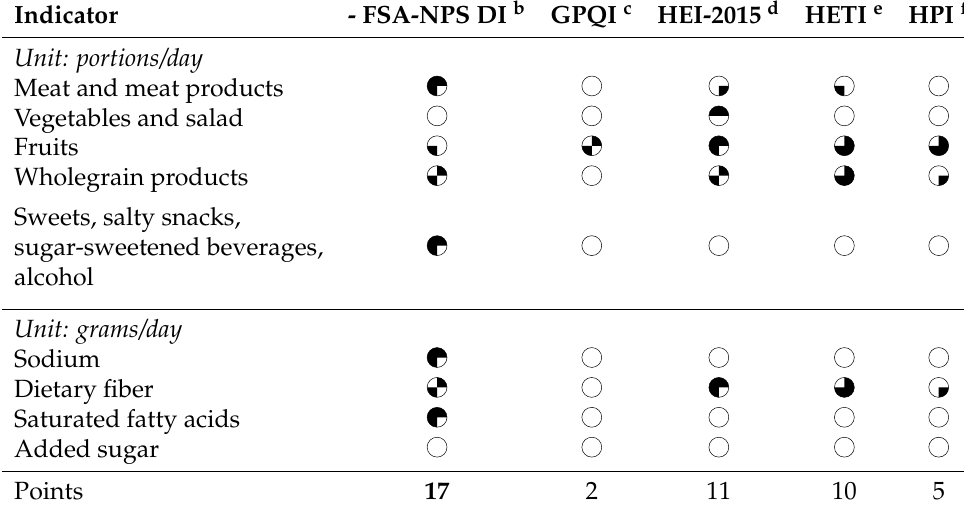
Table 6. Discrimination potential of relevant food shopping quality indicators to differentiate health- relevant individual daily nutritional intake a behavior ( absolute , i.e., weight-based), N =